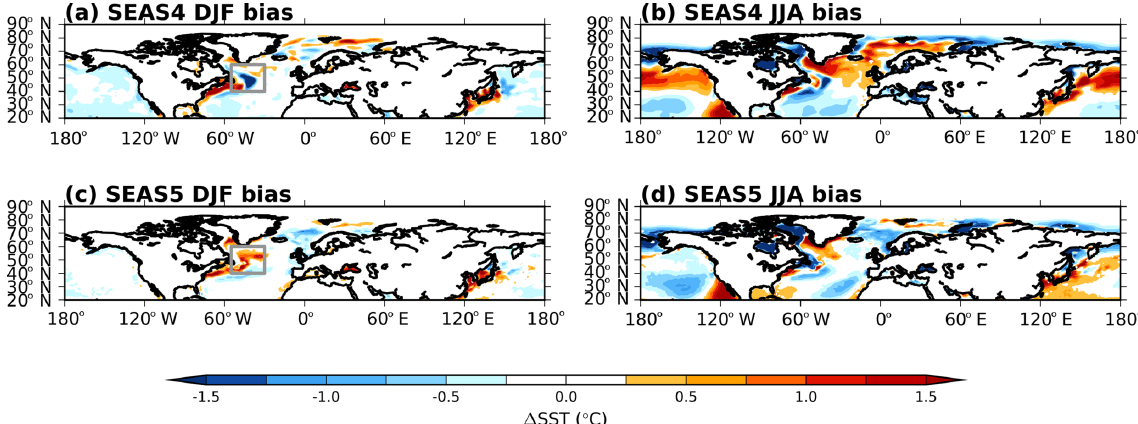
Figure 6. DJF and JJA SST bias in the northern extratropics at 1 month forecast lead for SEAS4 (a, b) and SEAS5 (c, d) compared to the analysis they were initialised from (ORAS4, ORAS5). The region discussed in detail later in Sect 4.2 is outlined in grey